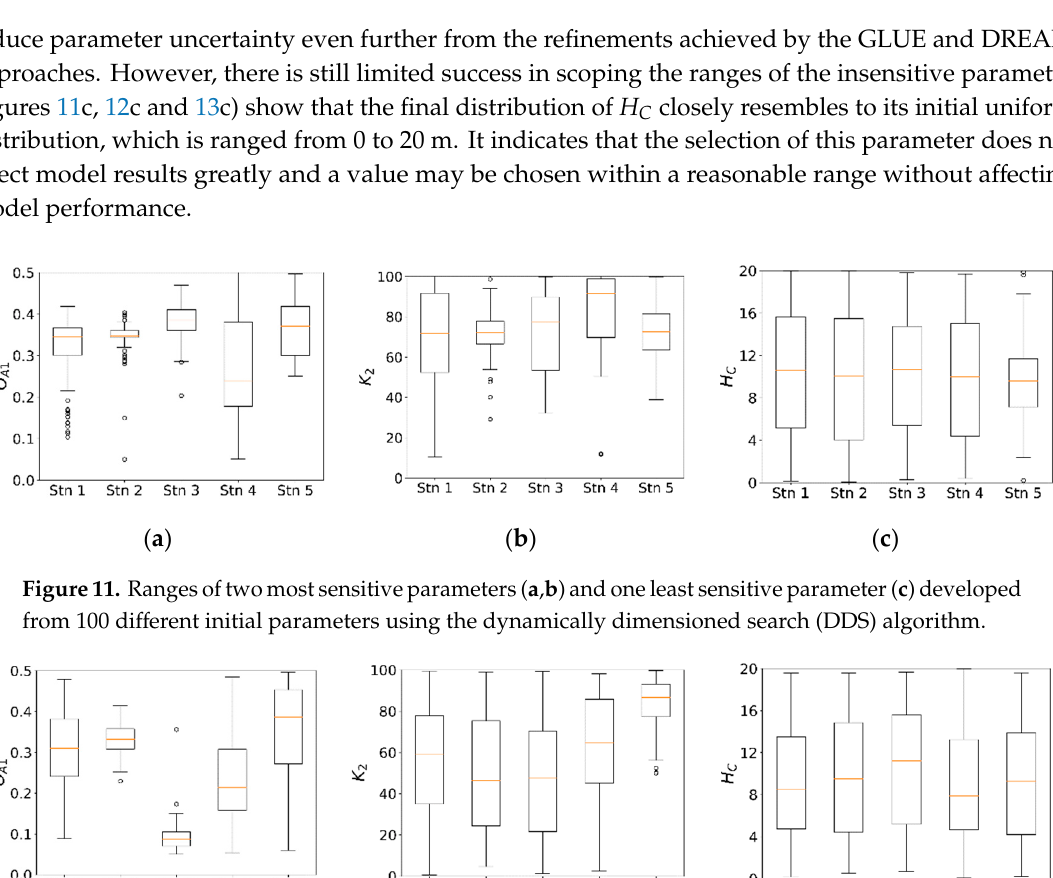
Figure 12. Ranges of two most sensitive parameters (( a ) and ( b )) and one least sensitive parameter ( c ) developed from 100 different initial parameters using the robust parameter estimation (ROPE) algorithm.